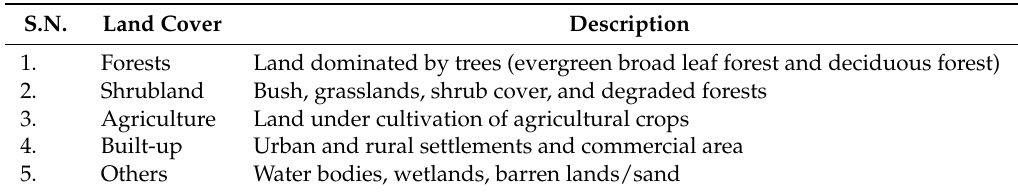
Table 1. Land use and land cover classification scheme in the study